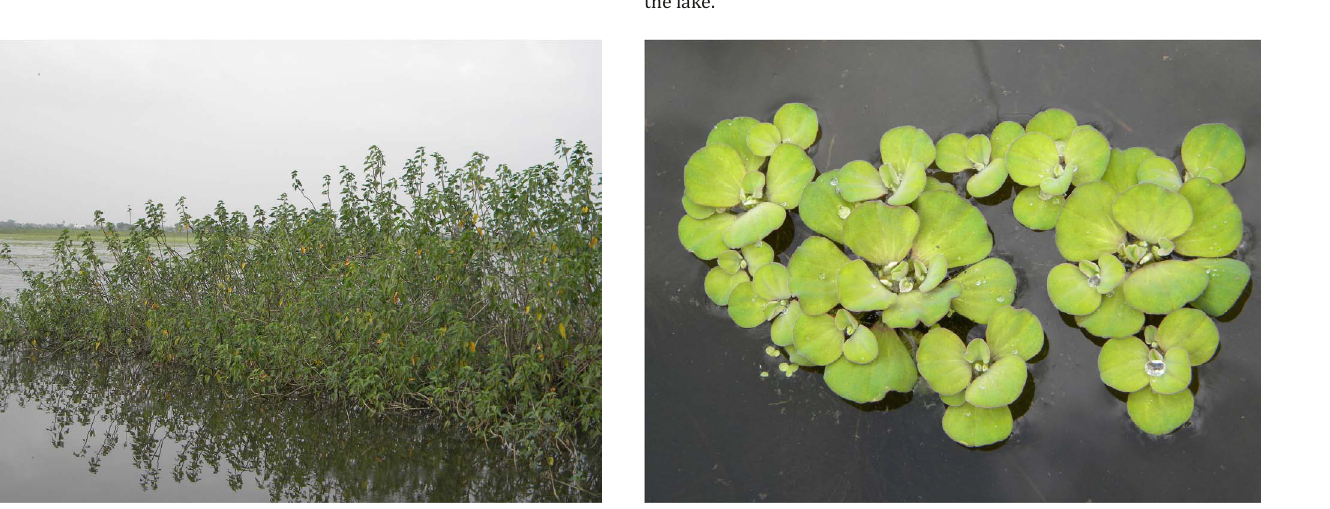
Figure 9. Ipomoea carnea an alien invasive weed.